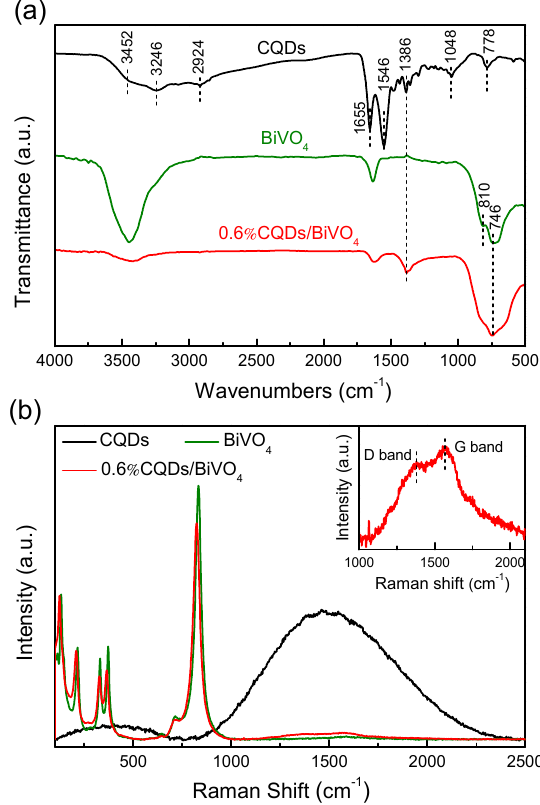
Figure 2. ( a ) FTIR spectra and ( b ) Raman spectra of CQDs, BiVO 4 , and 0.6%CQDs/BiVO 4 . Inset of ( b ) is the enlarged part of 0.6%CQDs/BiVO 4 at 1000–2100 cm − 1 .